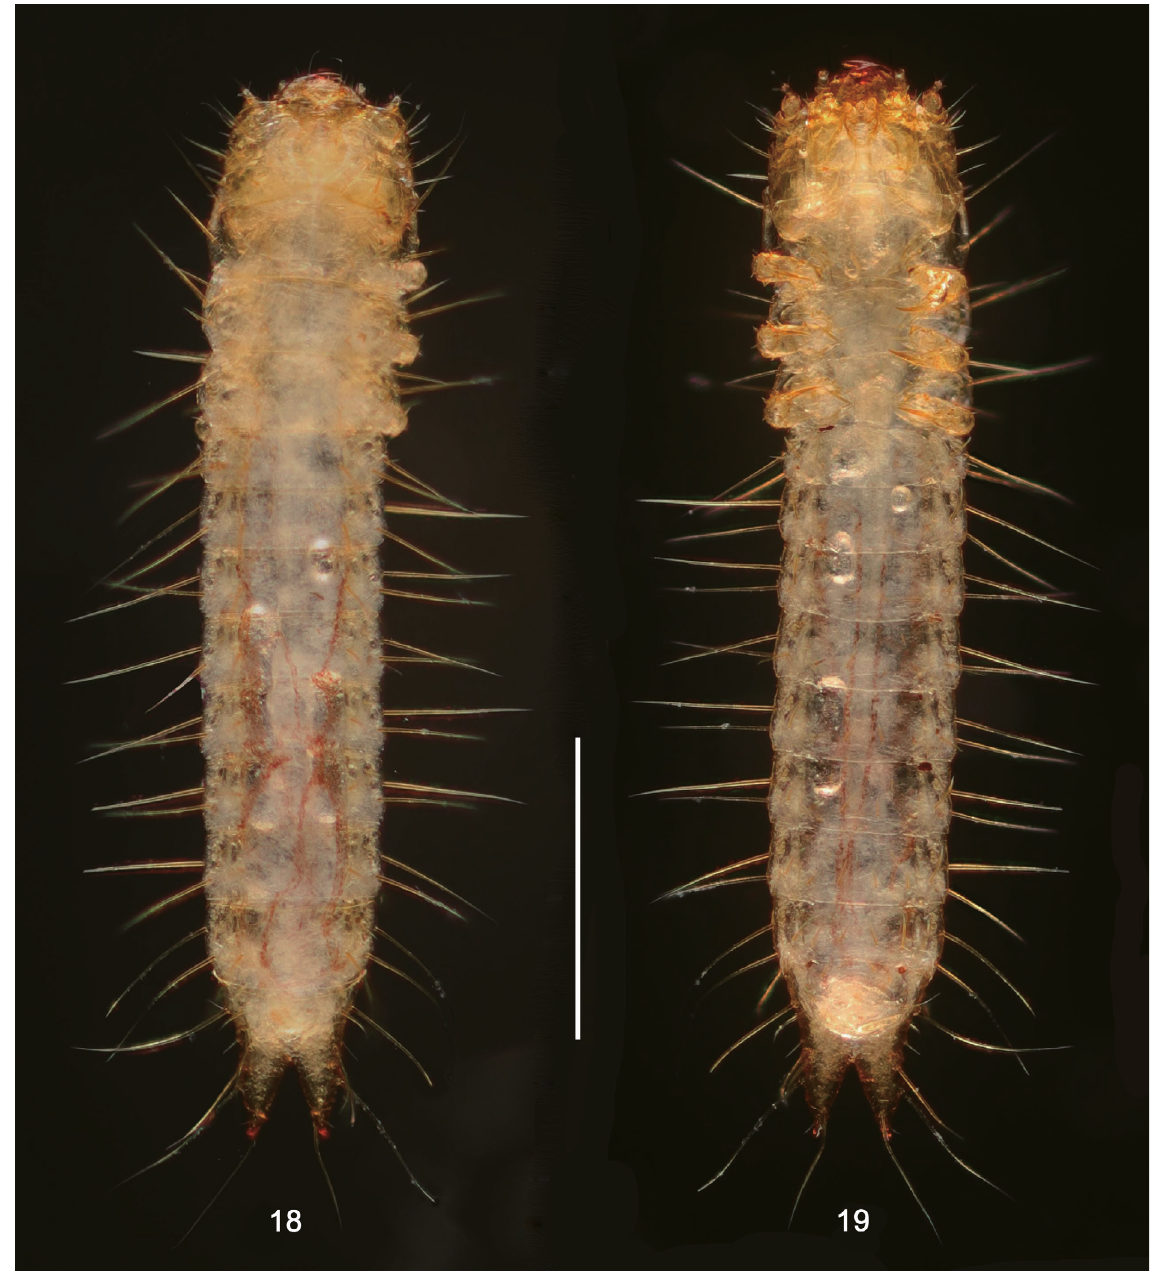
Figs 18–19. Habitus of first-instar larva of Trictenotoma formosana Kriesche, 1919. 18 . Dorsal view. 19 . Ventral view. Scale bar: